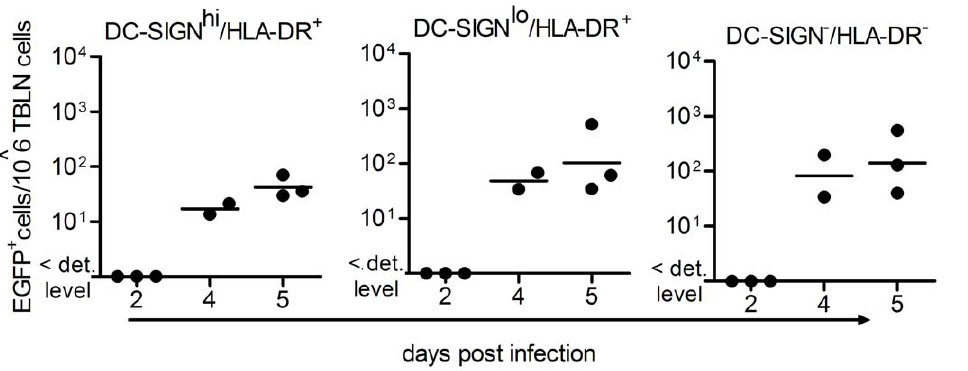
Figure 2. Infection in the tracheo-bronchial lymph nodes. Infection of the DC-SIGN hi , DC-SIGN lo and DC-SIGN - cells in TBLN from MV-infected macaques, determined by detection of EGFP in flow cytometry from 2–5 d.p.i. Each dot represents an individual animal. Lines indicate geometric means.